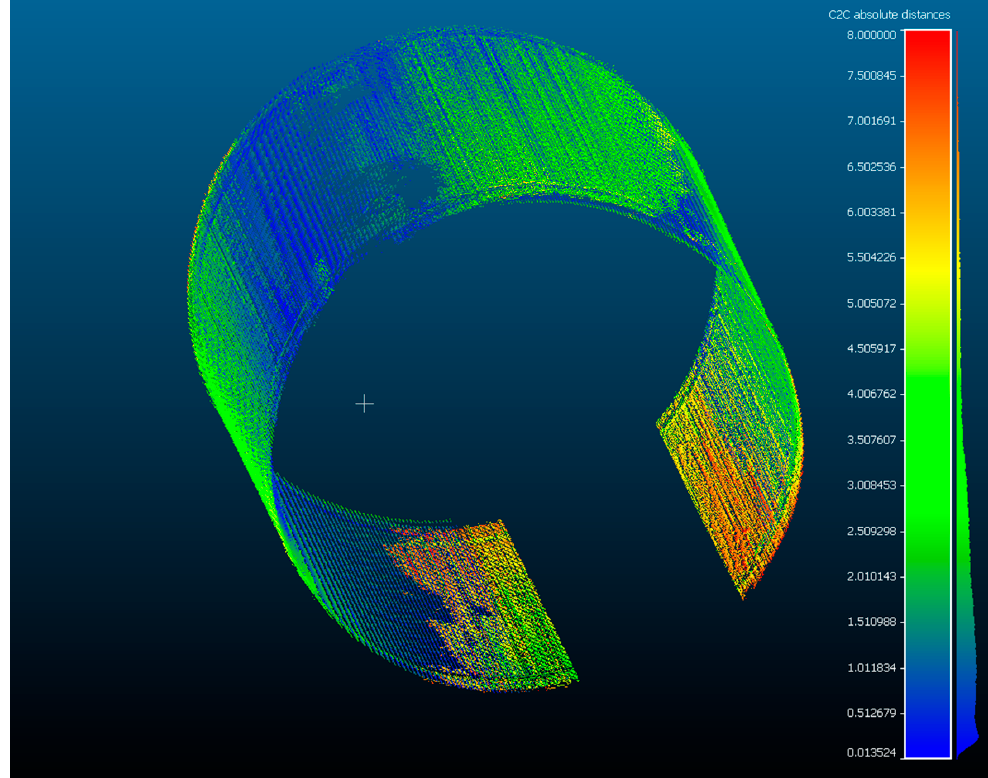
Figure 14. Visualization of the differences between the proposed scanner and the reference measurement on the example of a steel tube. The bottom of the tube was occluded during measurement.